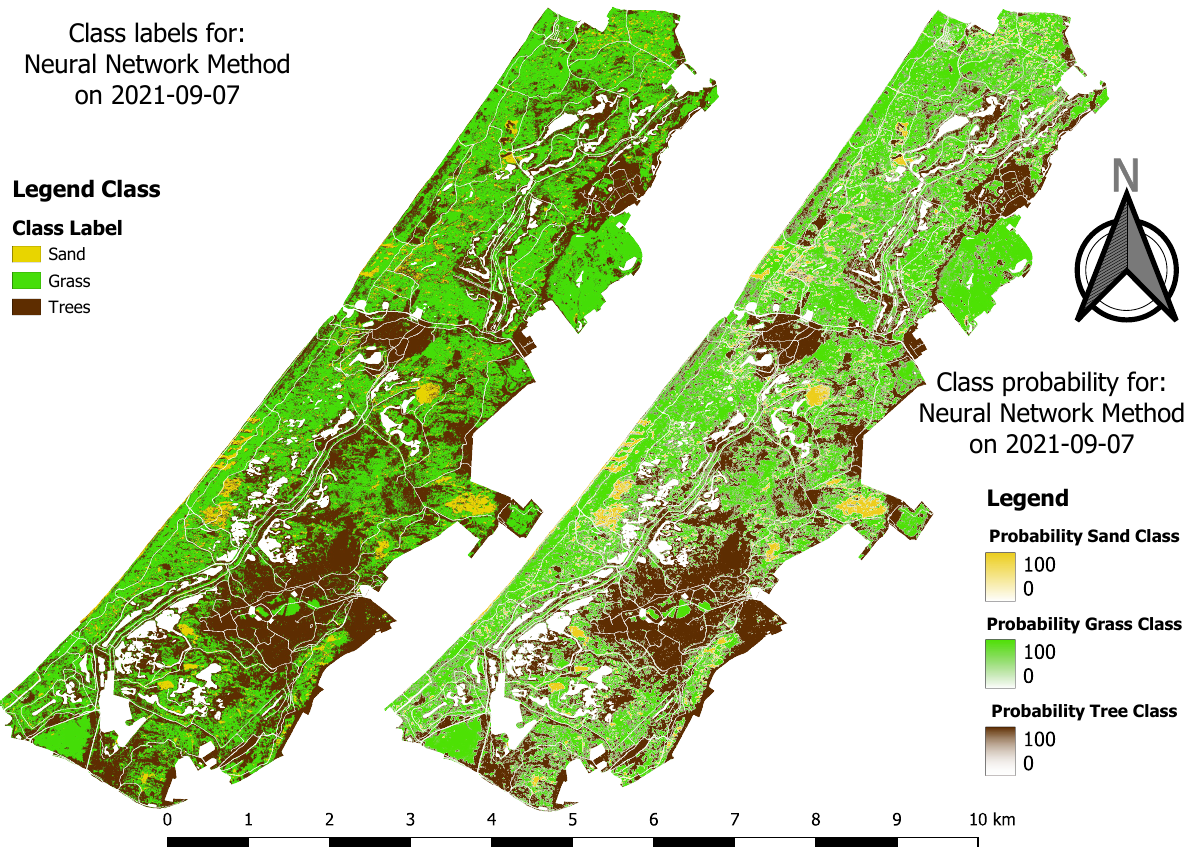
Figure 3. Left: Class labels as classified by the Neural Network method. Right: Probability of classes, grey pixel would mean low probability for every class.